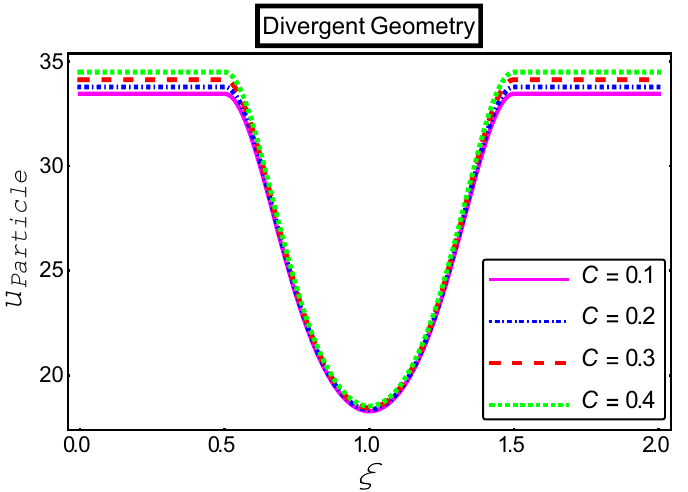
Figure 12. Impact of fluid velocity “ C ” parameters on particle velocity.